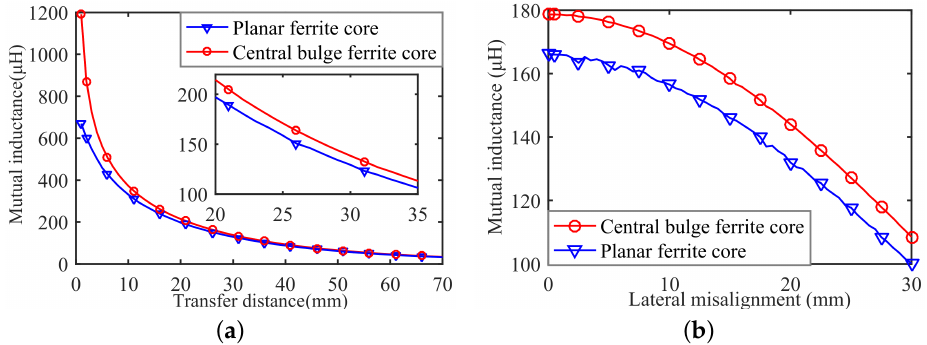
Figure 10. Comparison of two magnetic coupling structures’ magnetic line of force: ( a ) Curves of M when transmission distance changes; ( b ) Curves of M when lateral misalignment changes.